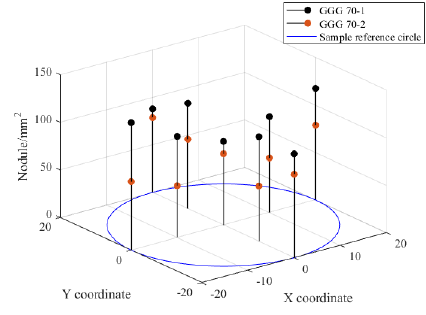
Figure 13. Nodule count in GGG70.